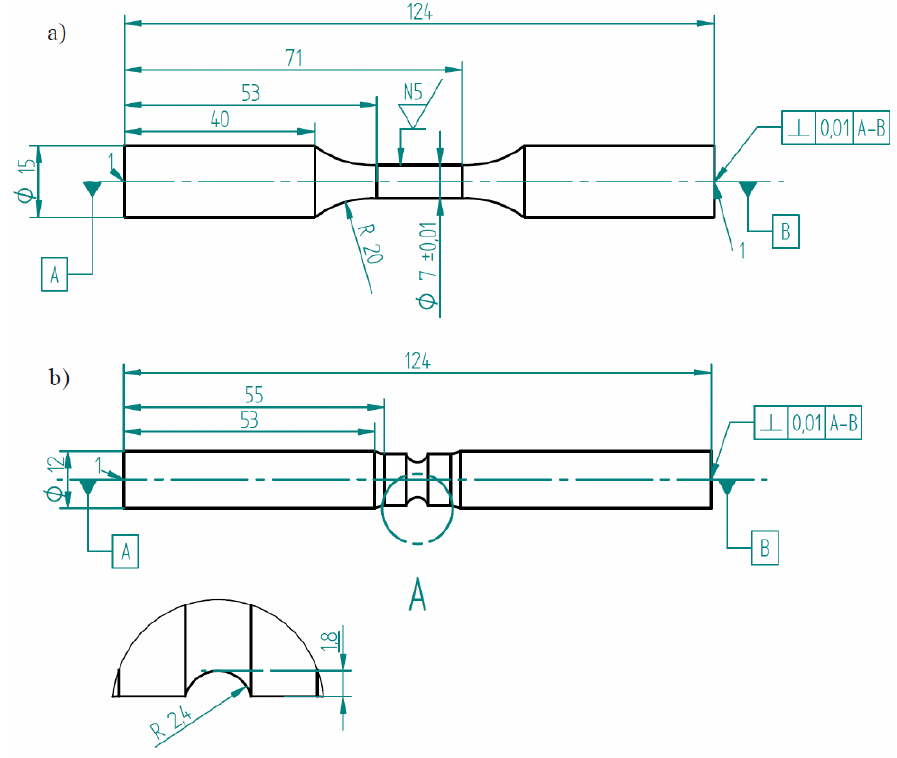
Figure 2. Geometry of the smooth ( a ) and notched ( b ) specimen in accordance to [14,21]. Isothermal LCF tests were carried out at 850 °C at a servo hydraulic MTS test rig with a maximum load capacity of 100 kN combined with an Hüttinger TrueHeat (TRUMPF Hüttinger GmbH, Germany, Freiburg) MF 5000 induction heating system. Strain-controlled tests were performed at R = − 1, using an MTS high-temperature extensometer type 632.53 with ceramic rods, a measurement length of 12 mm and a constant air flow cooling to prevent temperature influences on the measurement. All tests were carried out with a found in [17,21].